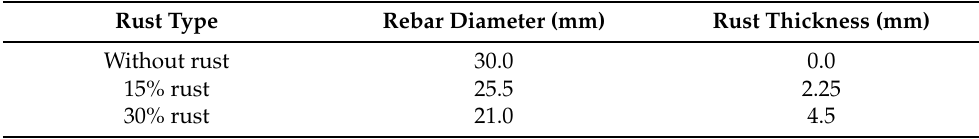
Table 2. Specifications of the rusted rebar for different